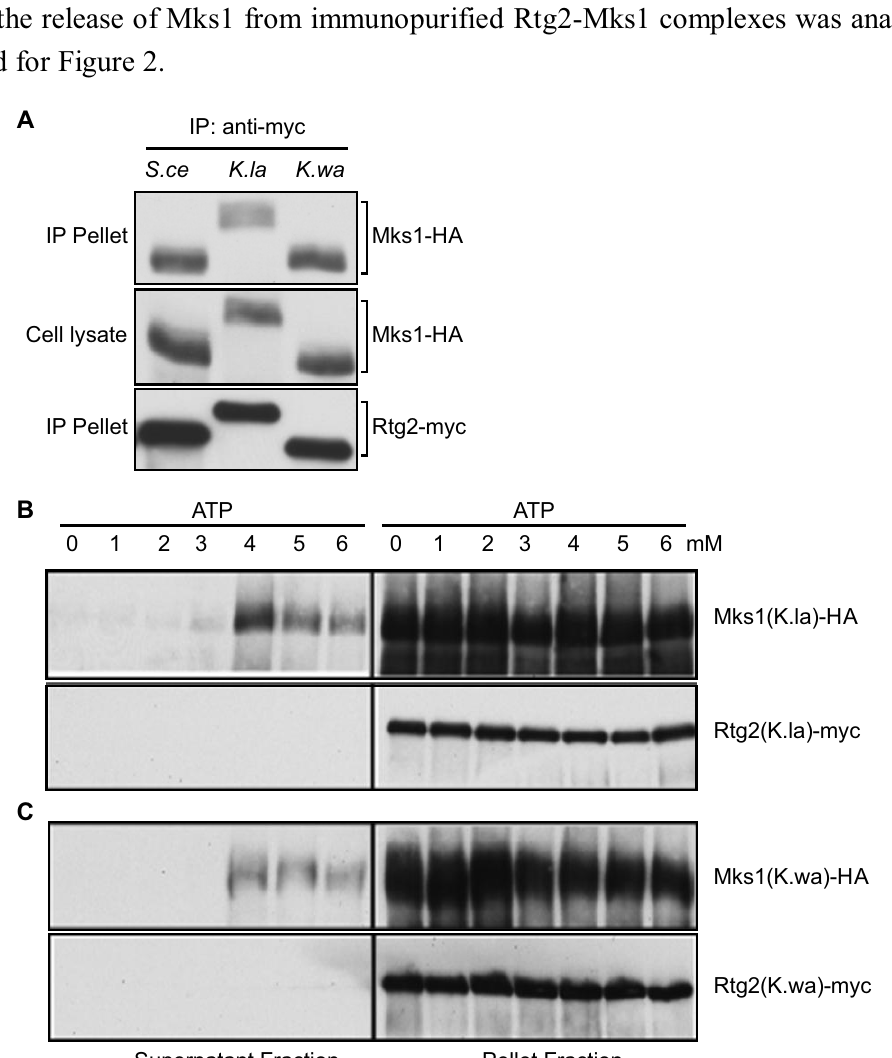
Figure 5. ATP releases Mks1 from Rtg2. ( A ) Rtg2 and Mks1 homologs from K. lactis and K. waltii form a complex. rtg2 (cid:39) mks1 (cid:39) double mutant cells (ZLY145) expressing pairs